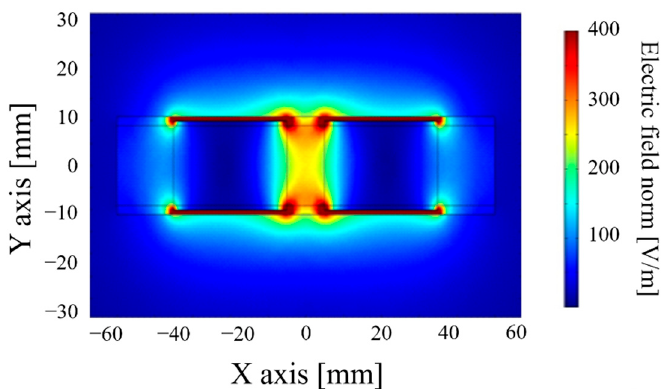
Figure 5. Electric density field for a 20 mm cylindrical sensor.